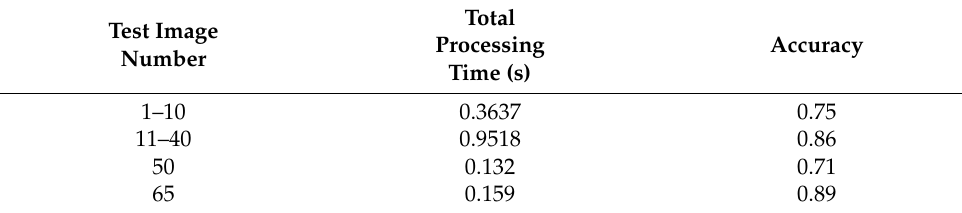
Table 9. The evaluation results of images of the car detection model.